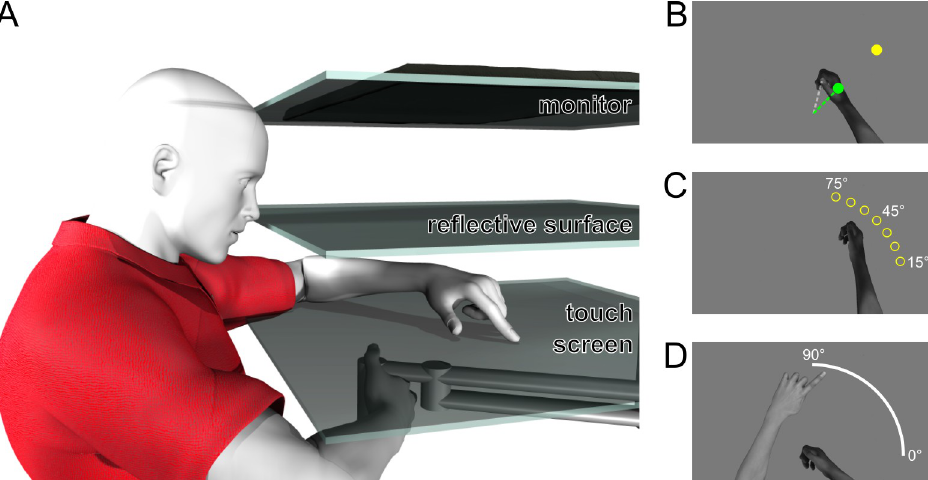
Fig 1. Setup and tasks. a) The participants held on to the handle of a robotic manipulandum with their unseen right hand. Visual feedback on hand position was provided through a mirror ( middle surface ) half-way between the hand and the monitor ( top surface ). A touchscreen located just above the hand was used to collect responses for the localization tasks ( bottom surface ). b) Training task. The target, shown as a yellow disc, is located 10 cm away from the home position at 45˚. In the rotated training tasks, the cursor (shown here as a green circle) represented the hand position rotated 30˚ relative to the home position. c) No-cursor reach task. Targets were located 10 cm away from the home position at 15˚, 25˚, 35˚, 45˚, 55˚, 65˚, and 75˚, shown by the yellow circles here (only one was shown on each trial). While reaching to one of these targets, no visual feedback on hand position was provided. d) Localization task. The participants’ unseen, right hands moved out and back, and subsequently participants indicated the direction of the hand movement by indicating a location on an arc using a touch screen with their visible left index finger.